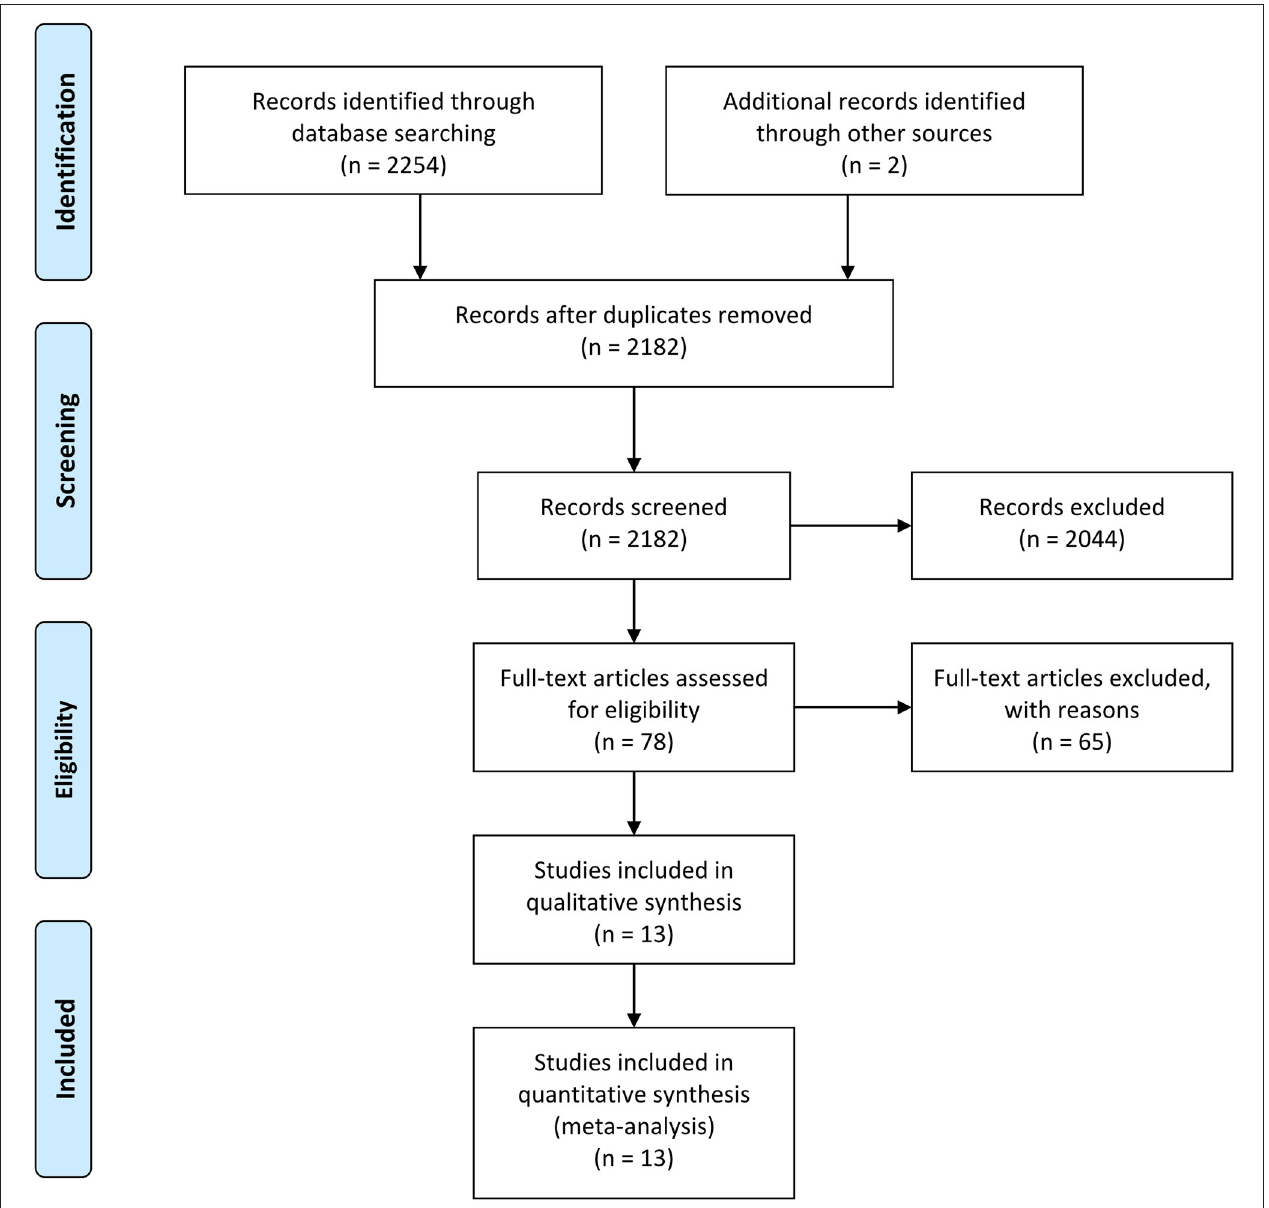
FIGURE 1 | PRISMA flow